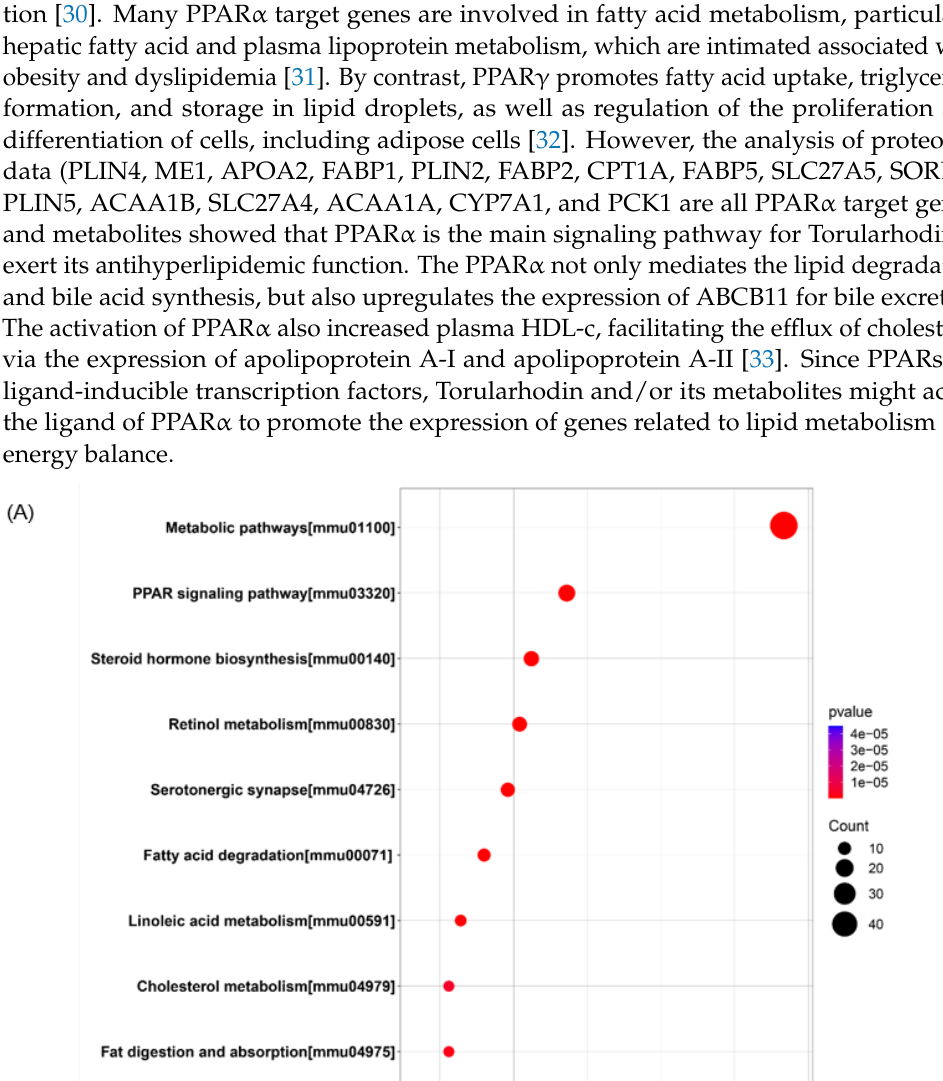
Figure 10. KEGG analysis of the signaling transduction pathways in Control vs. HFD ( A ) and HFD- T vs. HFD ( B ). PPARs are transcription factors regulating gene expression following ligand activa- tion [30] . Many PPARα target genes are involved in fatty acid metabolism, particularly hepatic fatty acid and plasma lipoprotein metabolism, which are intimated associated with obesity and dyslipidemia [31] . By contrast, PPARγ promotes fatty acid uptake, tri- glyceride formation, and storage in lipid droplets, as well as regulation of the proliferation